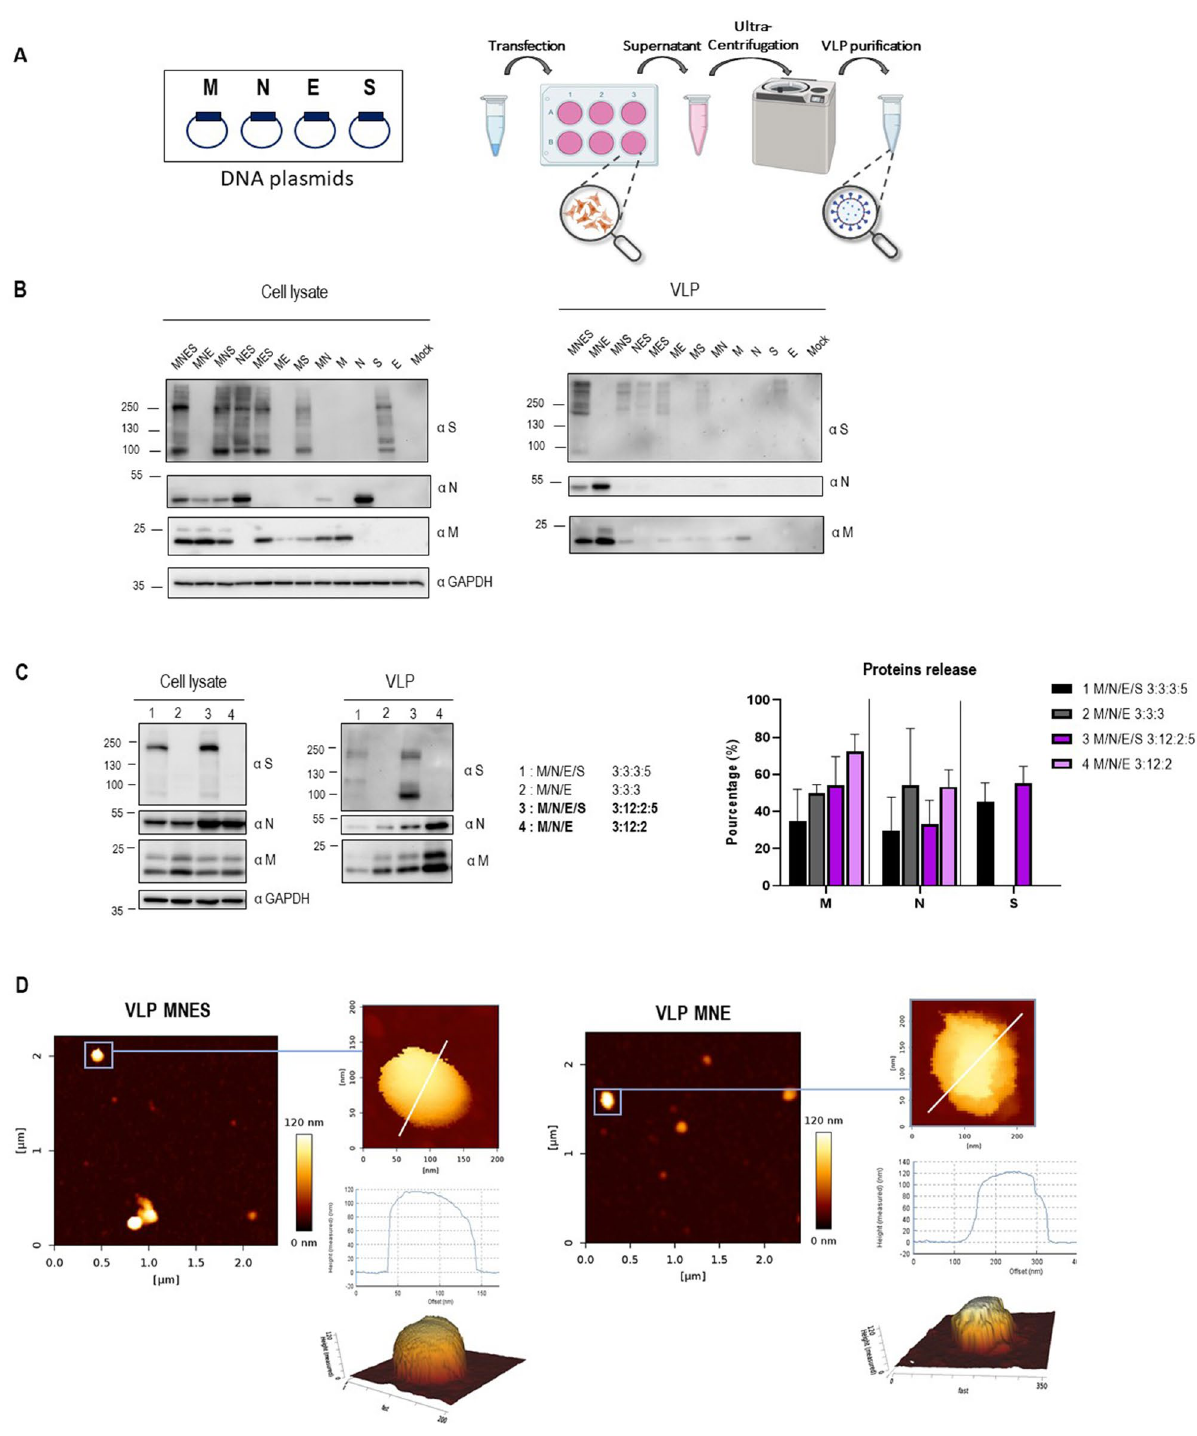
Figure 1. Optimization of SARS-CoV-2 VLPs assembly and particle analysis using immunoblots and atomic force microscopy imaging. ( A ) Scheme of VLPs production and purification. Thanks to BioRender for images. ( B ) Western blot of cell lysates and VLPs of HEK293T cells transfected with M, N, E or S as indicated for each lane. The transfected M/N/E/S plasmid ratios are respectively MNES 3:3:3:5; MNE 3:3:3; MNS: 3:3:5, NES 3:3:5, MES 3:3:5, ME 3:3, MS 3:5, M 3, N 3, E 3, S 5. N = 1. ( C ) Western blot of cell lysates and VLPs of HEK293T cells transfected with the indicated 3:3:3: ± 5 and 3:12:2: ± 5 M, N, E ± S transfected plasmid ratios. Right panel: Graph representing the percentage of M, N, E and S in released VLPs after quantification of the western blot band intensities for each condition. N = 3 independent experiments. ( D ) AFM imaging of SARS-CoV-2 MNES VLPs and MNE VLPs using quantitative QI mode AFM in TNE buffer. For each condition, a topographic image of 2.5 µm × 2.5 µm and zoom of a particle is shown, with a 3D projection. The color gradient for the Z scale is the same for all panels. The topographical profile plots along the white line are shown for each VLP. N = 2 with 18 VLP